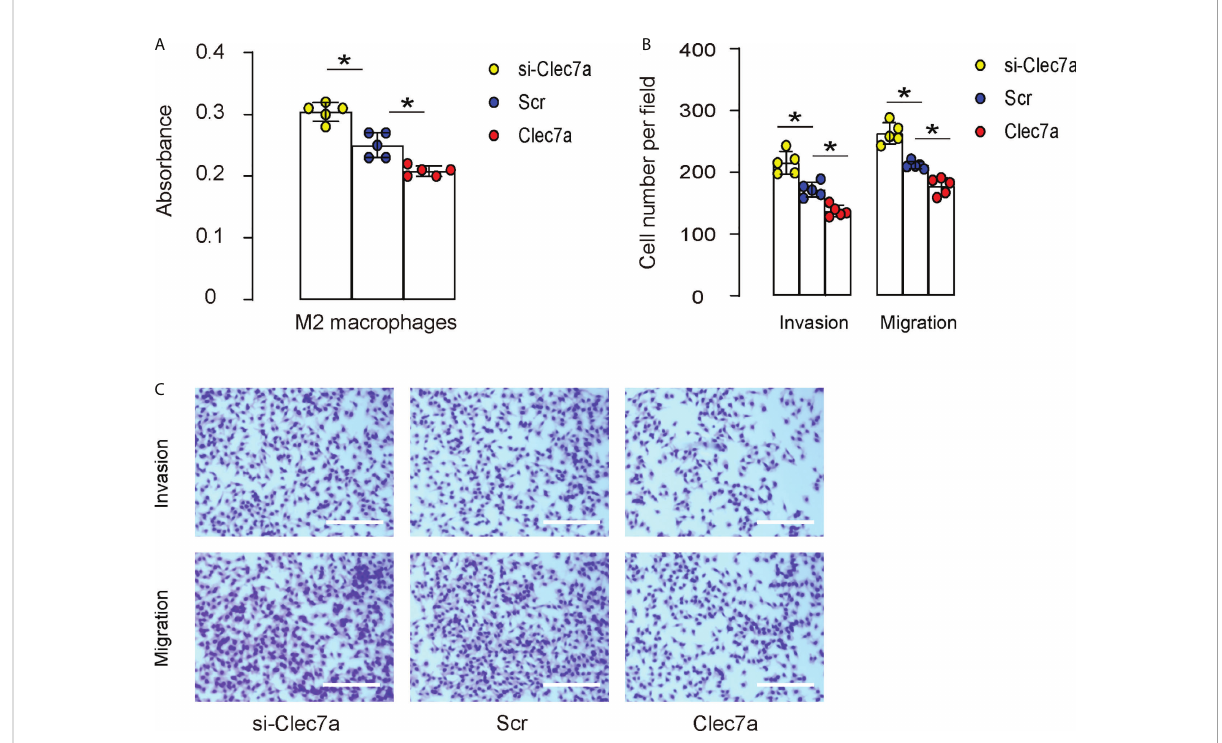
FIGURE 5 Clec7a depletion in M2 macrophages increases cell proliferation and migration. Cell growth, invasion and migration were measured in Clec7a or si-Clec7a transfected IL-4-primed M2 macrophages. (A) CCK-8 assay. (B, C) Cell invasion and migration assay, shown by quanti fi cation (B) and by representative images (C) . *p<0.05. Scale bars are